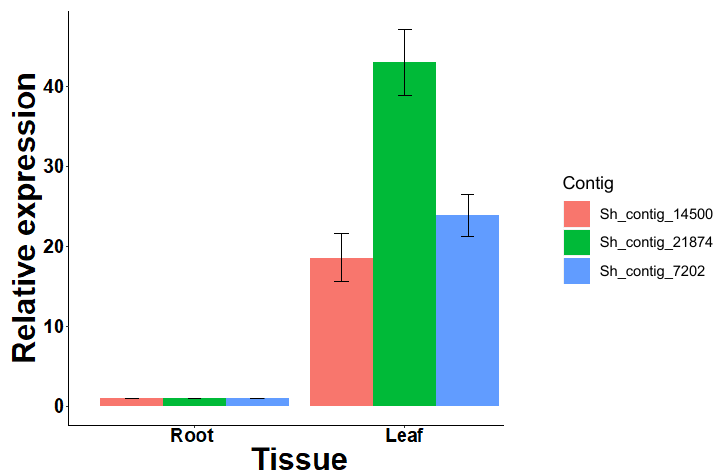
Figure 5. Relative expression analysis of putative riboflavin and thiamine biosynthetic genes in S. hispanica leaf and root tissues. Error bars represent the standard error of the mean (SEM). Asterisks indicate significant differences compared to the controls ( P < 0.05; Student’s t-test).